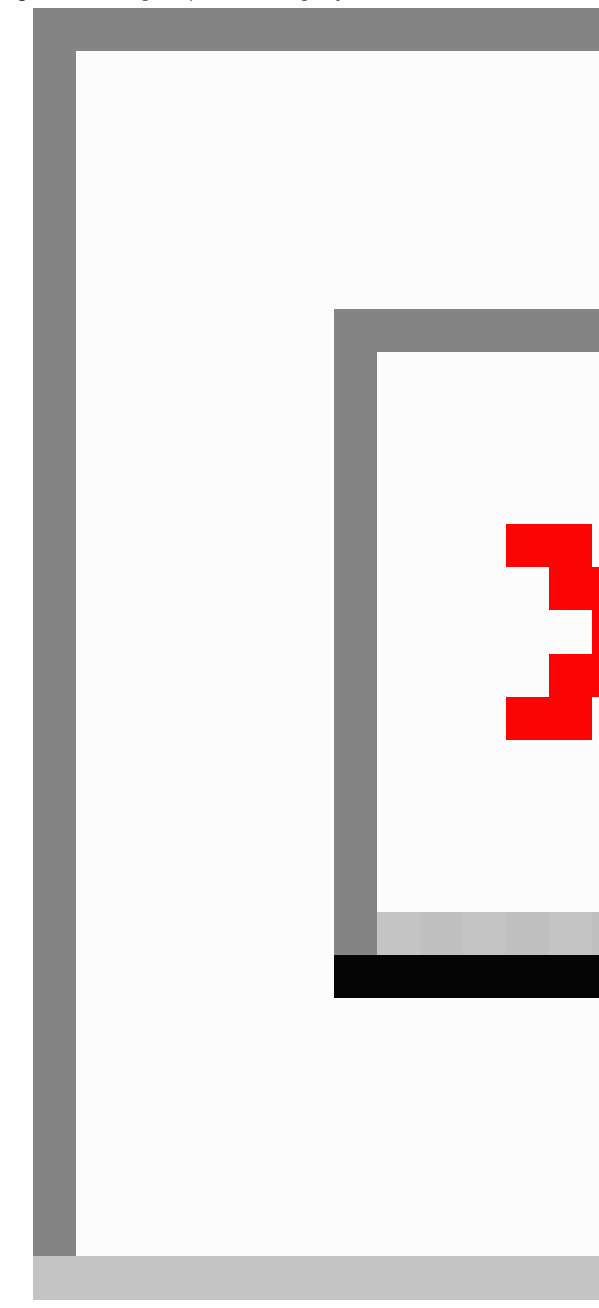
Figure 4. Average step-count change by